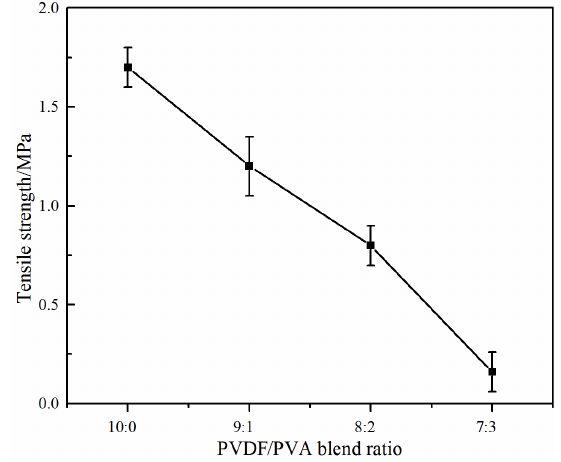
Figure 6. Effect of the PVDF/PVA blend ratio on tensile strength (total polymer concentration of 20 wt %).